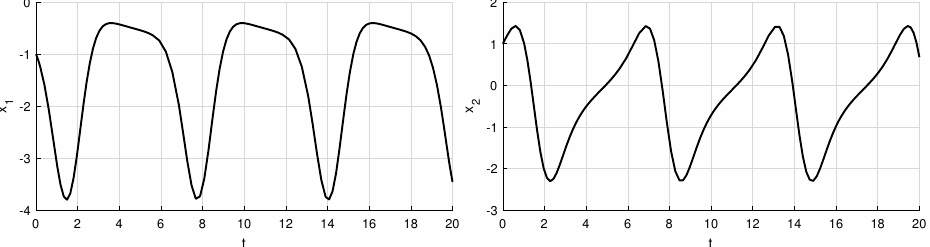
Figure 2. Simulation result for Example 3 with β ( t ) = cos t and γ = − sin t and the initial state x ( 0 ) = ( − 1 1 ) T . Flow of the state − variables x 1 and x 2